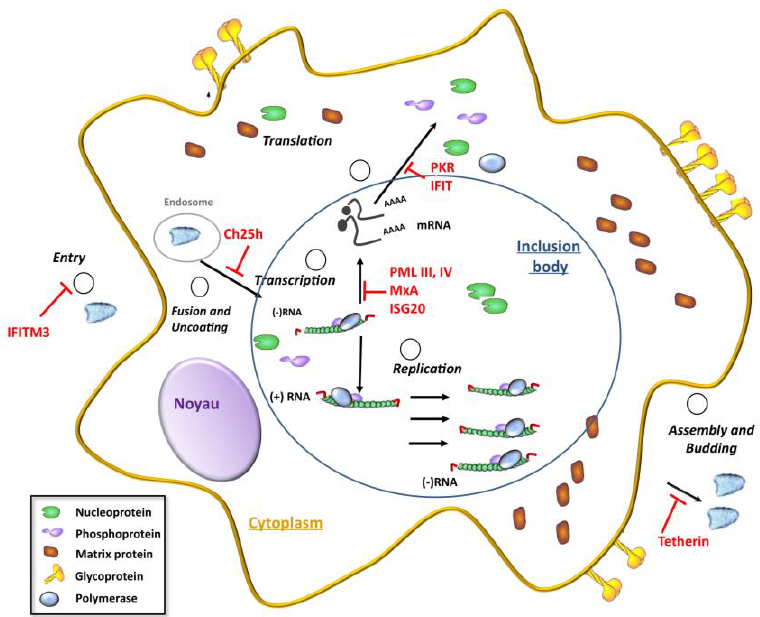
Figure 1. Figure 1. The different steps of the rhabdovirus cycle inhibited by interferon (IFN)- IFN-inducible transmembrane (IFITM) stimulated gene (ISG) products. IFN-inducible transmembrane (IFITM) proteins block viral entry, CH25h impairs the virus cell-fusion step by inducing cellular membrane changes, MxA inhibits primary transcription, ISG20 and ProMyelocytic Leukemia (PML) inhibit secondary transcription, protein kinase (PKR) and IFIT proteins inhibit viral translation and Tetherin prevents release of virions from the cell.